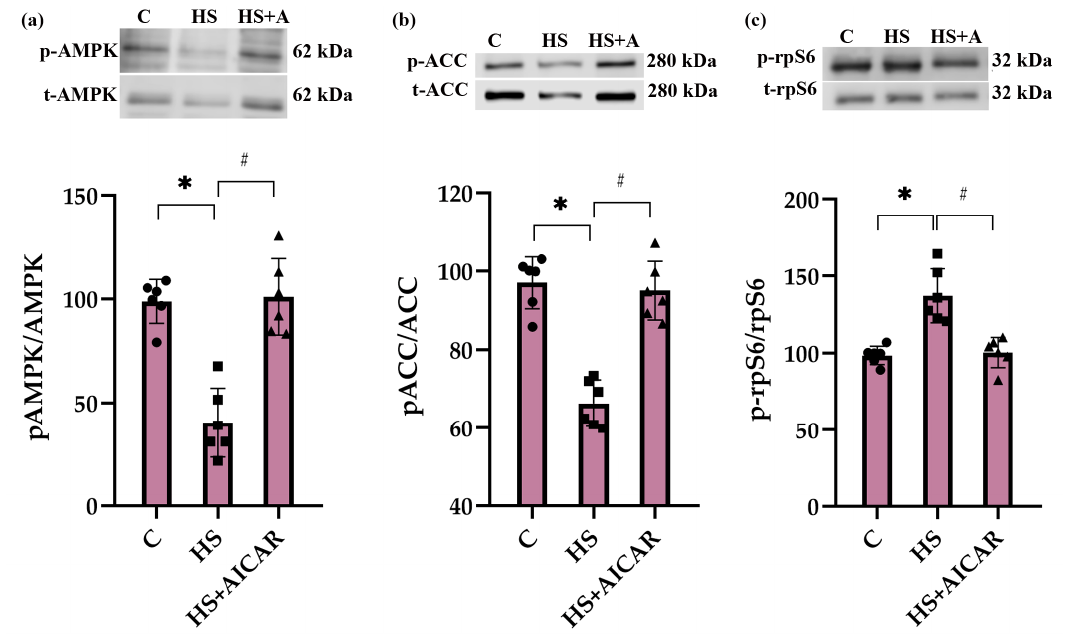
Figure 2. Effect of AICAR treatment on phosphorylation status of ( a ) AMPK (Thr172), ( b ) ACC (Ser79) and ( c ) rpS6 (Ser 240/244) in differentiating myoblasts derived from the atrophied rat soleus muscle. C—myoblasts derived from rat soleus muscle of the control rats, HS—myoblasts derived from rat soleus muscle after 7-day HS, HS+AICAR—myoblasts derived from rat soleus muscle after 7-day HS and treated with AICAR. Values are means ± SEM, expressed as % of the C. Dots, squares and triangles on the bars represent individual data points. n = 6, *— p < 0.05 vs. C; #— p < 0.05 vs. HS.